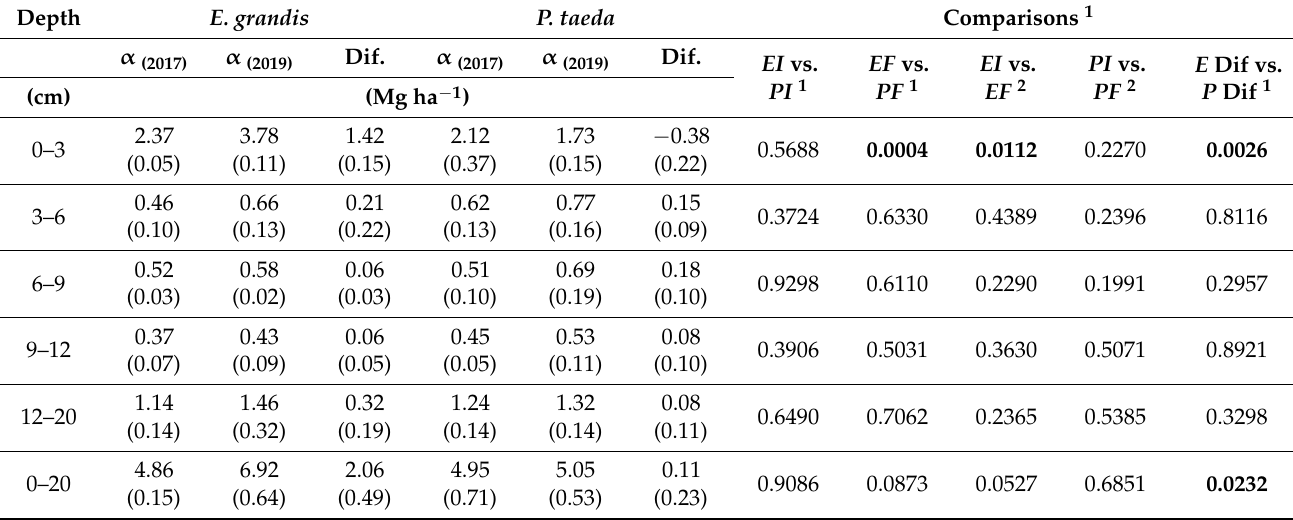
Table 10. Young SOC stock under P. taeda , E. grandis and native pastures at the beginning and end of the study. Depth E. grandis P. taeda Comparisons